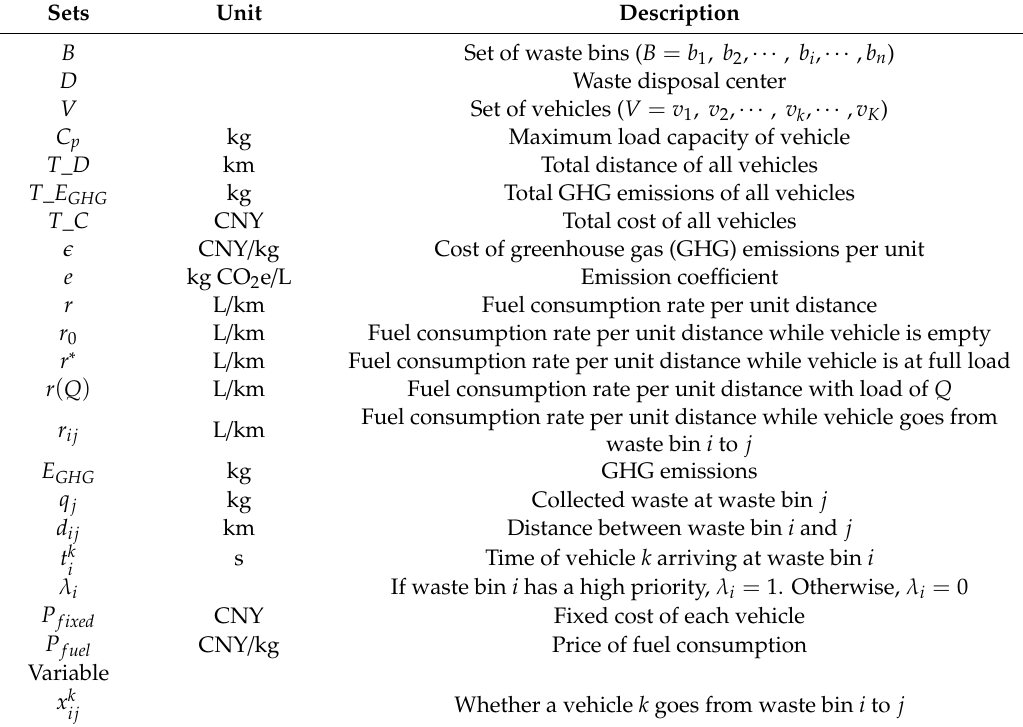
Table 1. Notation of the priority considered green vehicle routing problem (PCGVRP) model.